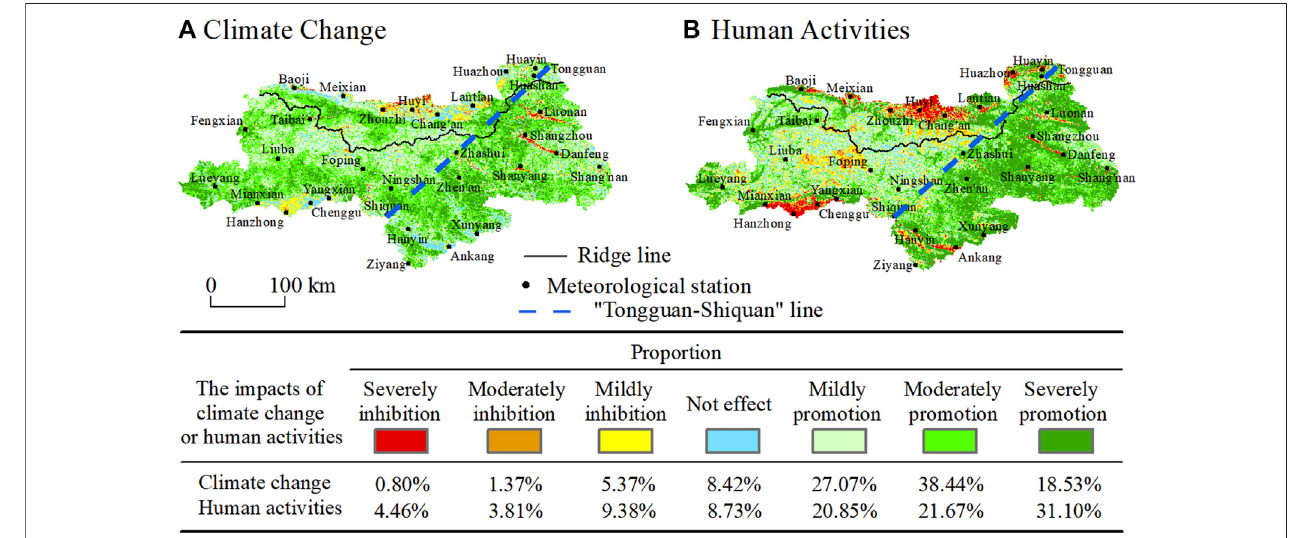
FIGURE 4 | Spatial distribution of the impacts of climate change and human activities on vegetation restoration in the Qinling Mountains during 2000 – 2019.